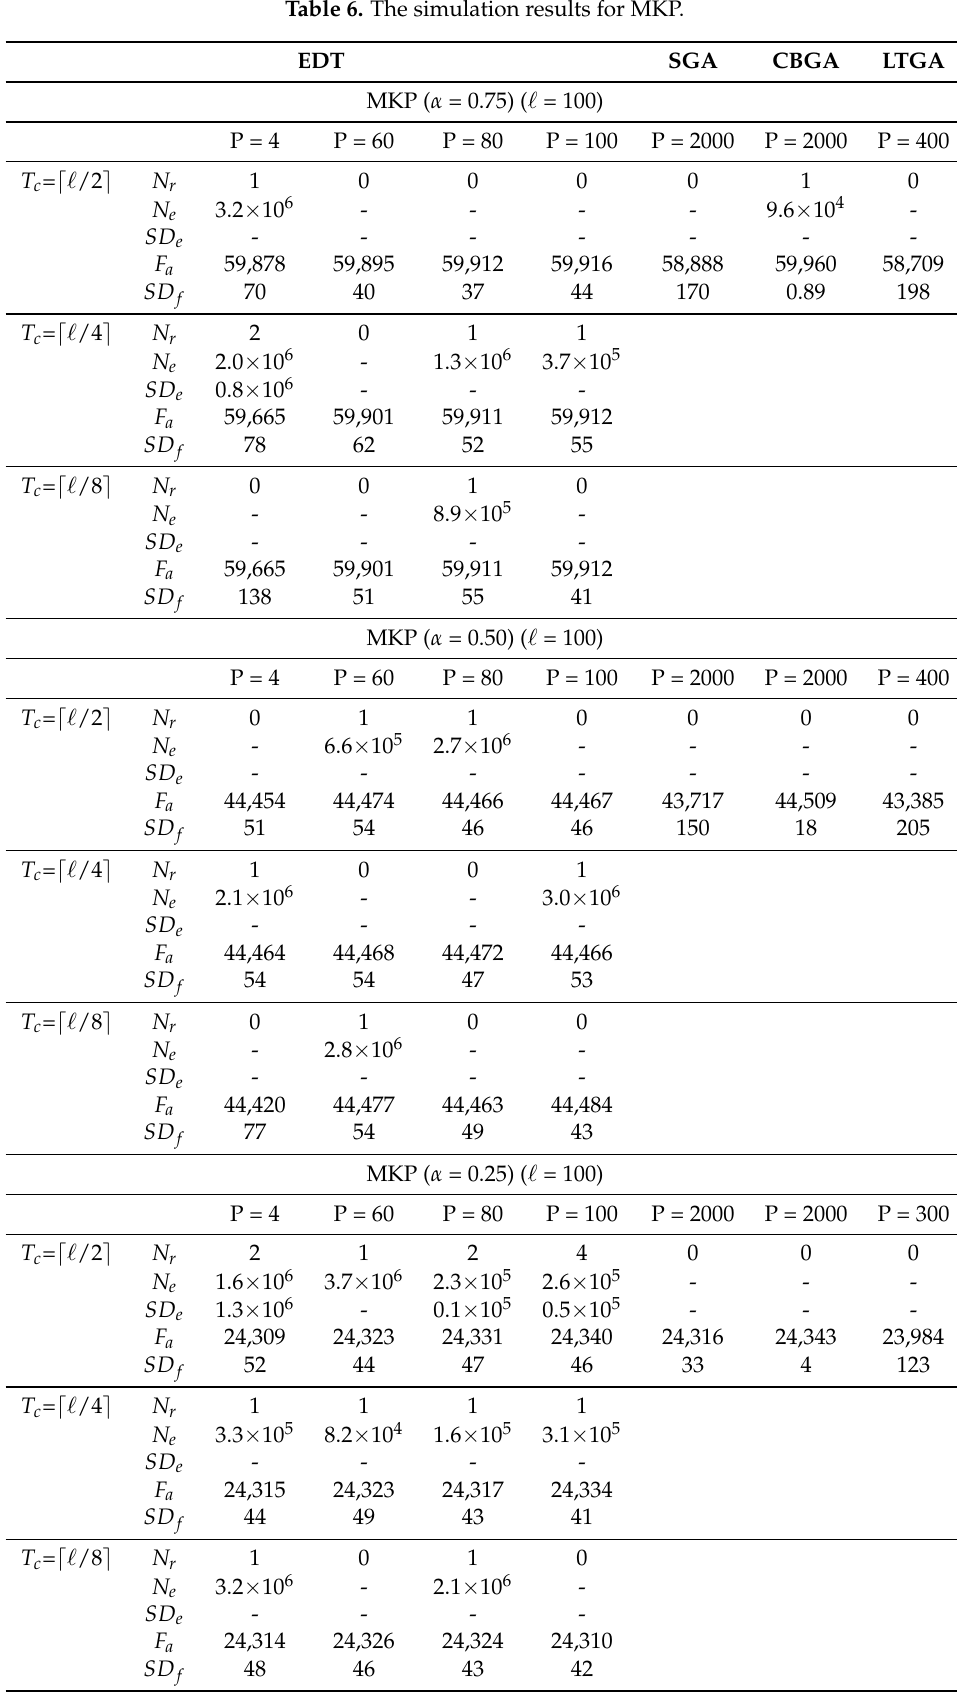
Table 6. The simulation results for